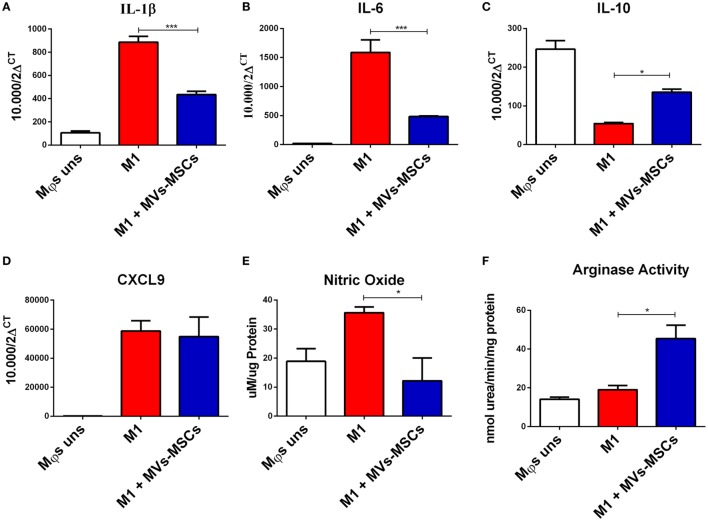
Global expression of inflammation and oxidation-associated molecules in M1-Mϕs treated or not with MVs-MSCs. (A) IL-1β expression; (B) IL-6 expression; (C) IL-10 expression; (D) CXCL9 expression; (E) nitric oxide production; and (F) activity of arginase in M1-Mϕs. MVs-MSCs are shown to efficiently modulate the pro-inflammatory and oxidative status in M1-Mϕs (*P < 0.05, **P < 0.01, ***P < 0.001).